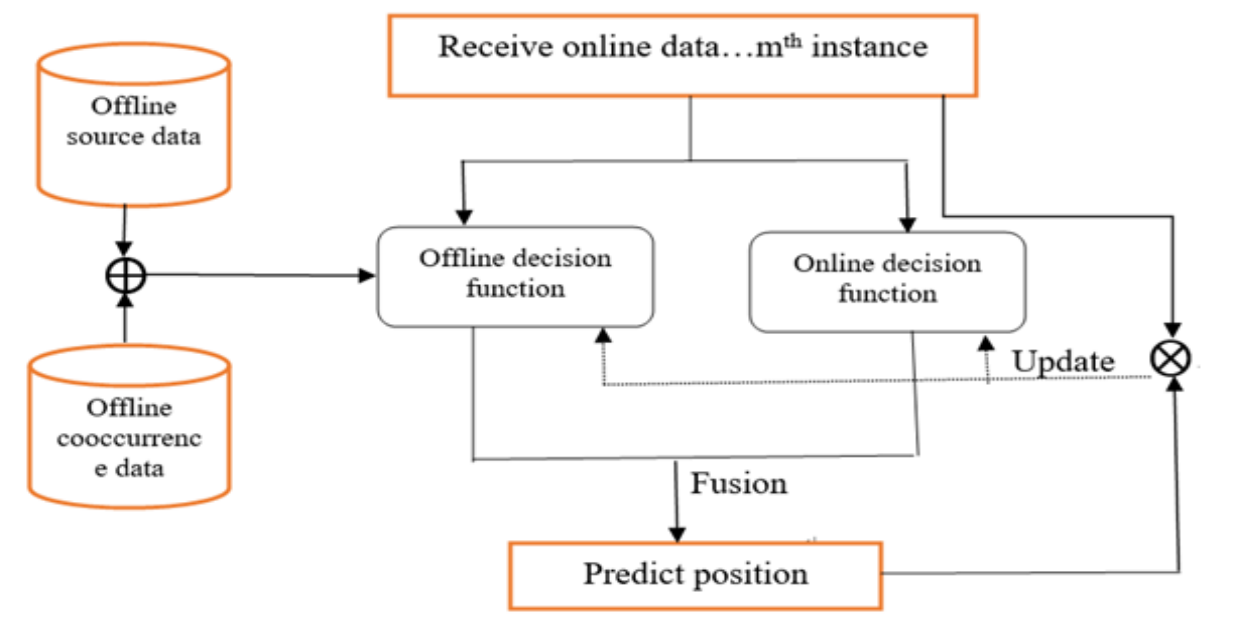
Figure 2. Proposed framework of heterogenous transfer learning-based weight co-occurrence for indoor positioning.